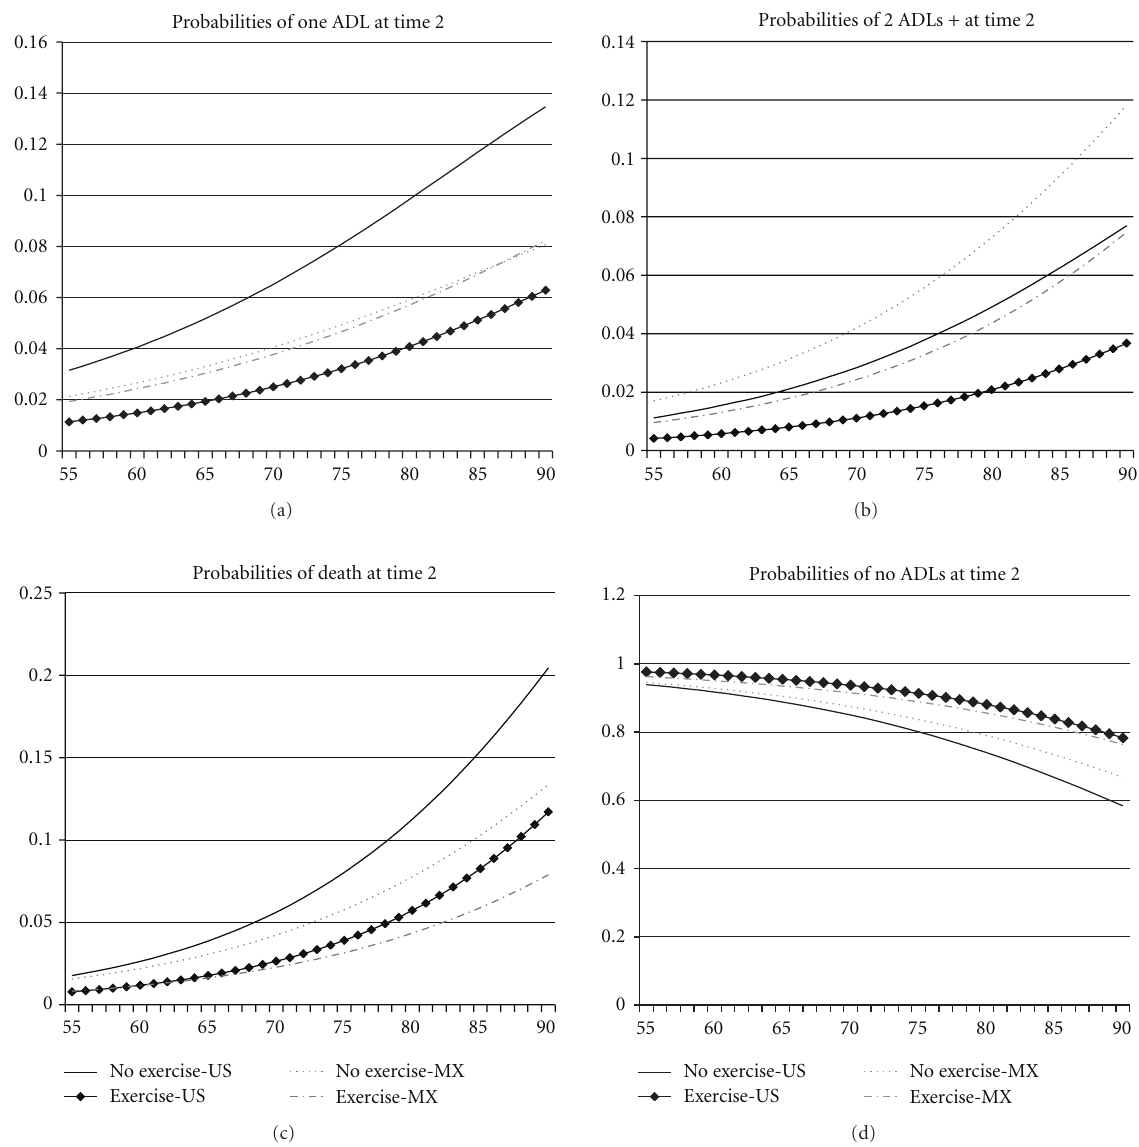
Figure 2: Probabilities of outcome at time 2, by country, exercise, and age for persons without ADL limitations at time